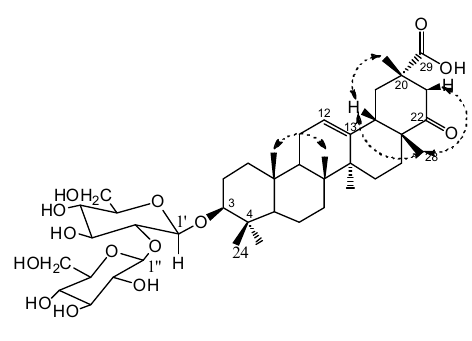
Figure 3. Key NOESY correlations of 1